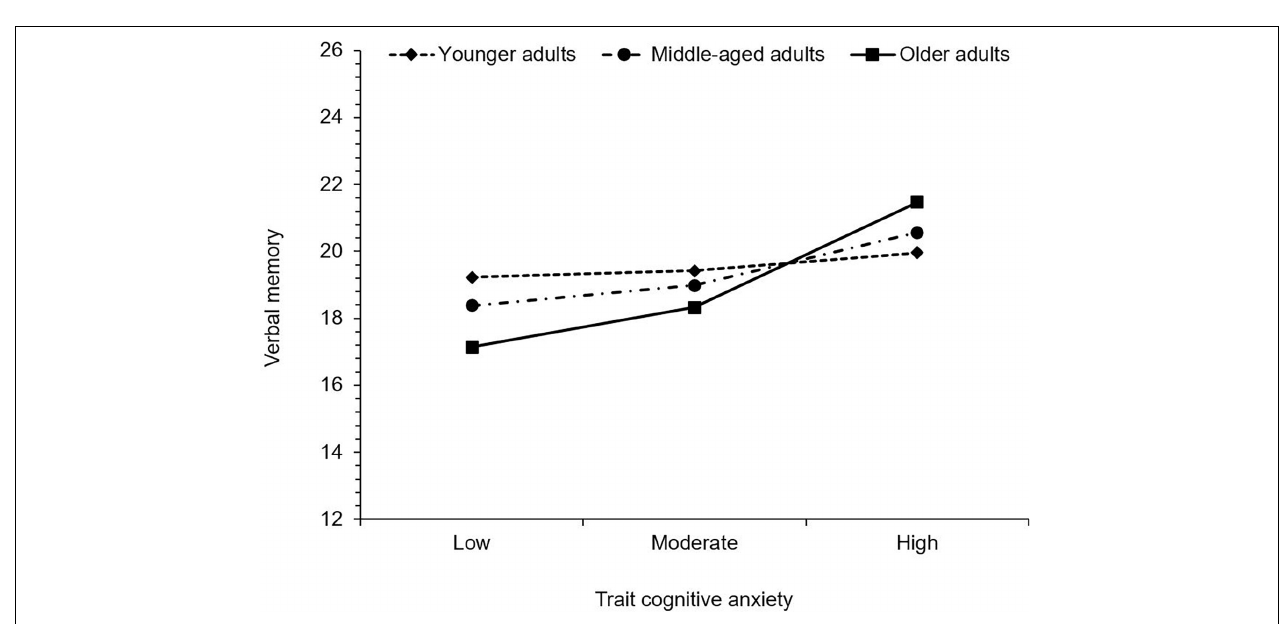
FIGURE 1 | Simple slopes illustrating the significant interaction between trait cognitive anxiety and age on attention. Higher values indicate greater levels of subjective cognitive difficulty.